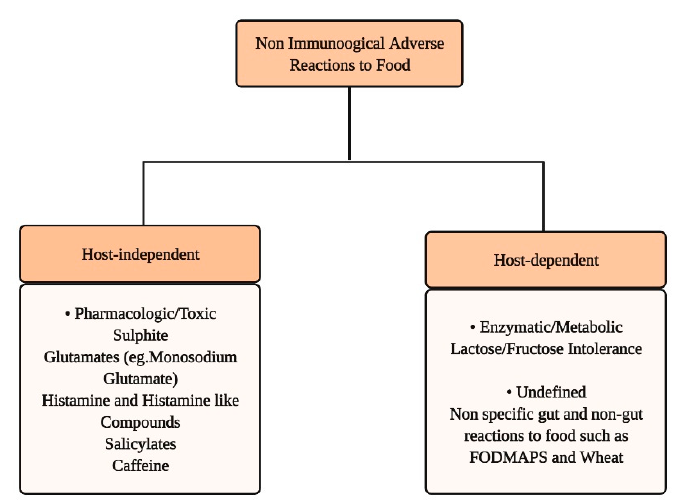
Figure 4. Non-immunologic adverse reactions to Figure 4. Non ‐ immunologic adverse reactions to food.